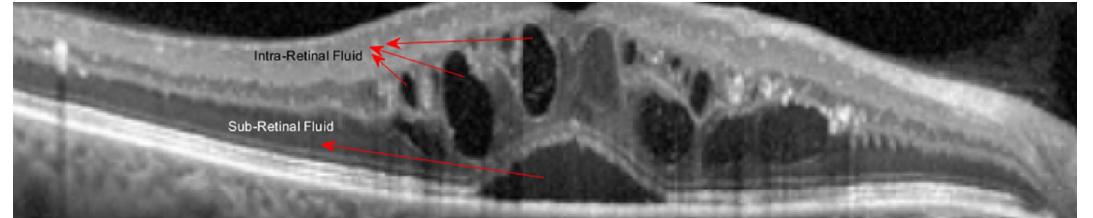
Figure 2. An OCT B-scan including SRF and